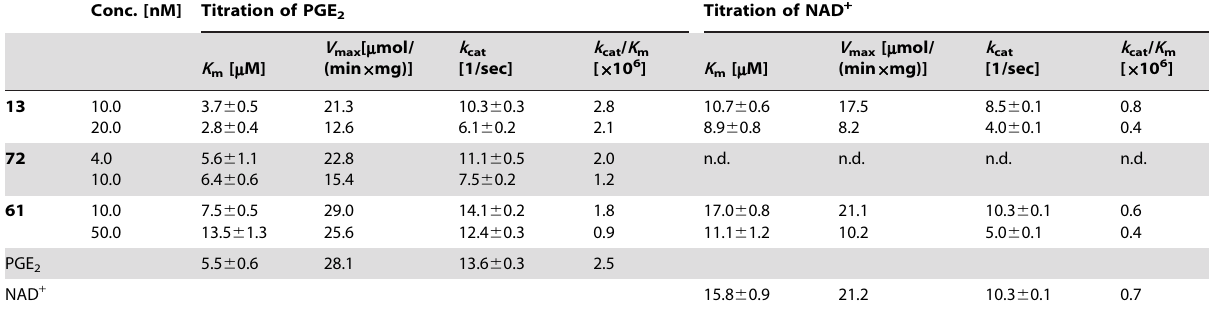
Table 1. Investigation of the mechanism of action for selected inhibitors of human